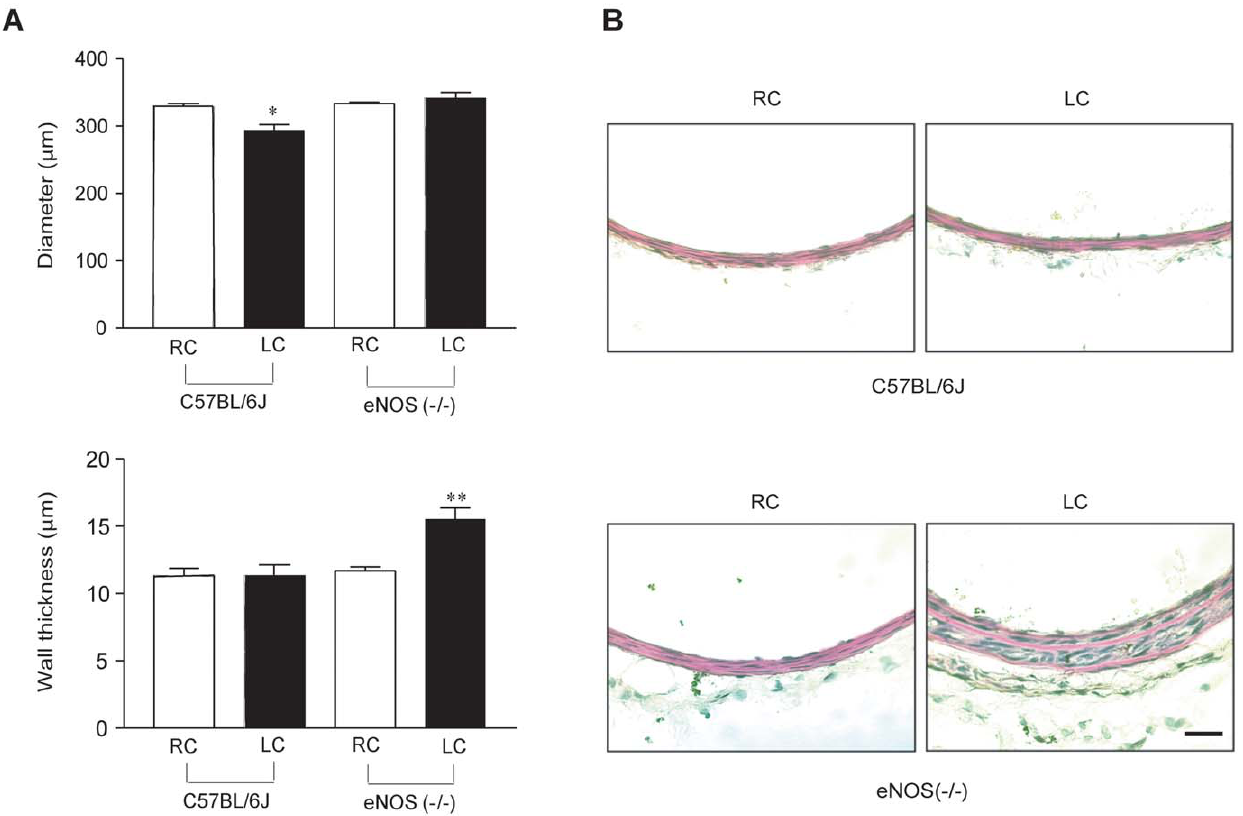
Figure 1. Impaired vascular remodeling in congenic eNOS knockout mice. (A) Morphometric analysis showing reductions in lumen diameter of LC in C57BL/6J mice with no change in wall thickness in response to a remodeling stimulus, yet no change in lumen diameter but an increase in wall thickness in LC of eNOS ( 2 / 2 ) mice. (B) Hematoxylin and eosin staining showing RC and remodeled LC from a C57BL/6J mouse (upper panel) and RC and remodeled LC from an eNOS ( 2 / 2 ) mouse (lower panel). Scale bar represents 25 m m. Values are mean 6 SEM; * P , 0.05, ** P , 0.01 with one way ANOVA with Bonferroni posttest; n=5 for each group of mice.